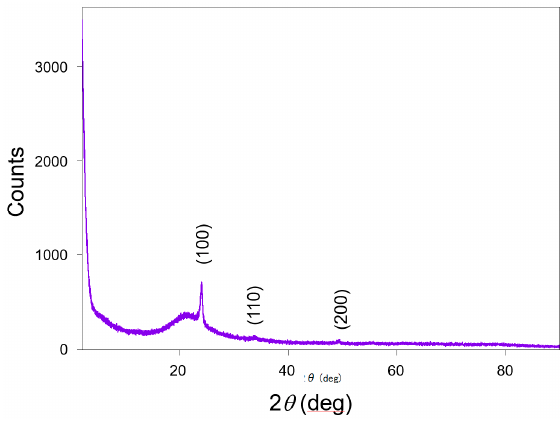
Figure 4. Atomic force microscopy images of the surface of the WO 3 layer over areas of ( a ) 10 × 10 µ m 2 and ( b ) 100 × 100 µ m 2 . R a denotes average roughness.